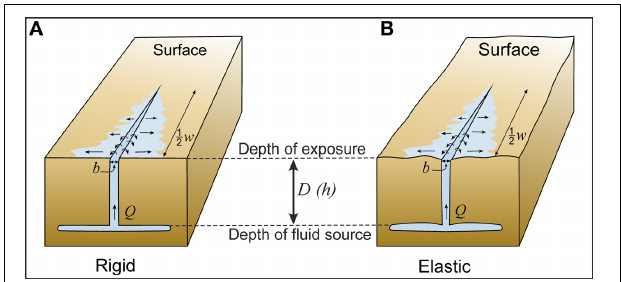
FIGURE 5 | Schematic model of a vertical hydrofracture initiated from a horizontal sill below the present exposure at a depth h below the present exposure. h is the height of a fracture, which for a vertical fracture is equal to its dip dimension D along which fluid flow Q takes place. W is the width of the fracture perpendicular to the flow direction. For a vertical through-going fracture W is equal to its outcrop length L . b is the fracture aperture in an outcrop. (A) In a rigid host rock, the fracture and the sill are self-supporting and the shape of a hydrofracture does not depend on its fluid pressure. (B) In an elastic host rock, the shape of a hydrofracture depends on its fluid overpressure, the fracture and the sill deform during fluid transport, and buoyancy has to be taken into